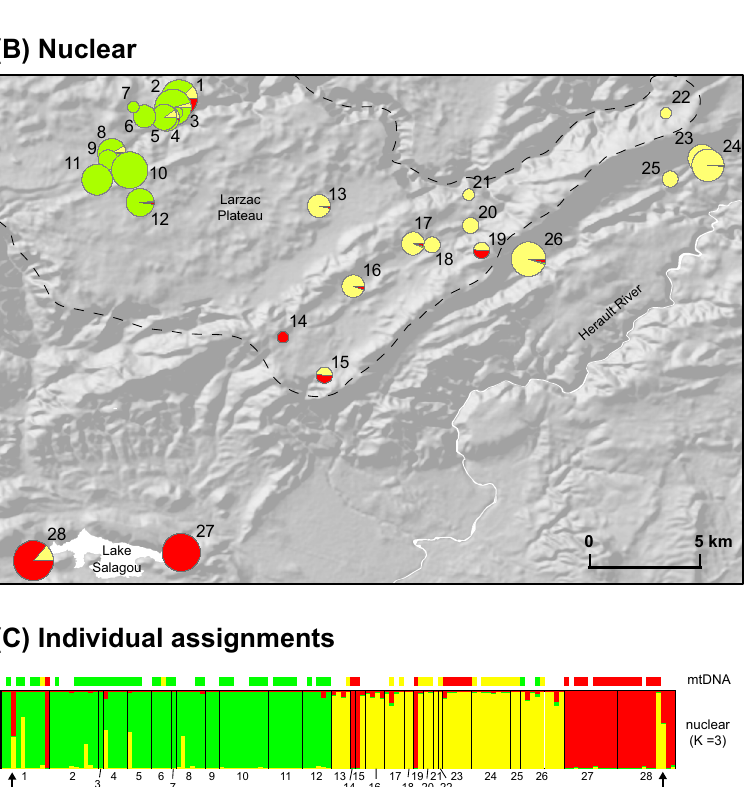
Figure 2. ( A ) Distribution of mitochondrial lineages, ( B ) nuclear clusters in the study area based on STRUCTURE average admixture proportions (for K = 3) and ( C ) individual STRUCTURE admixture proportions and mitotypes. Pie charts are proportional to sample sizes. Barplots show individual assignment for K = 3 (best solution according to the Pr(X │ K) statistic) and mitotypes. The dash line delimits the Larzac Plateau. Red: P. perezi , yellow: P. kurtmuelleri , green: P. ridibundus . Arrows highlight the two individuals identified as a hypothetical P. kurtmuelleri × P. perezi new klepton. The maps were built using ArcGIS 9.3 (http://